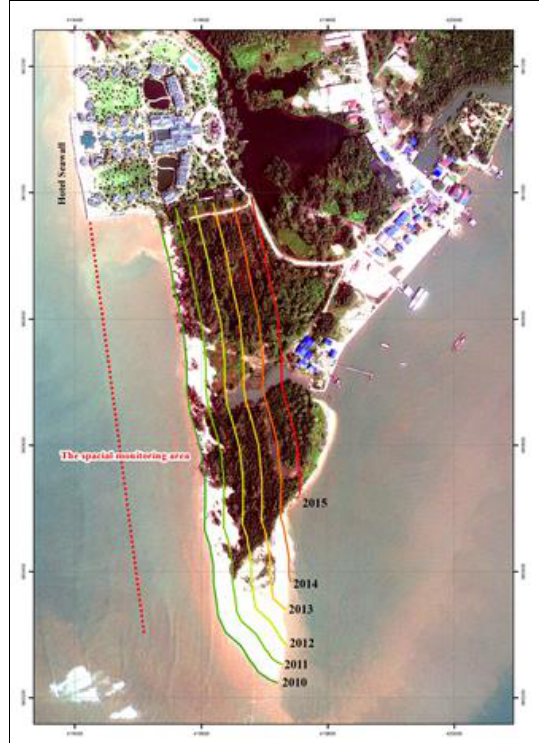
Figure 4. The prediction of previous study of